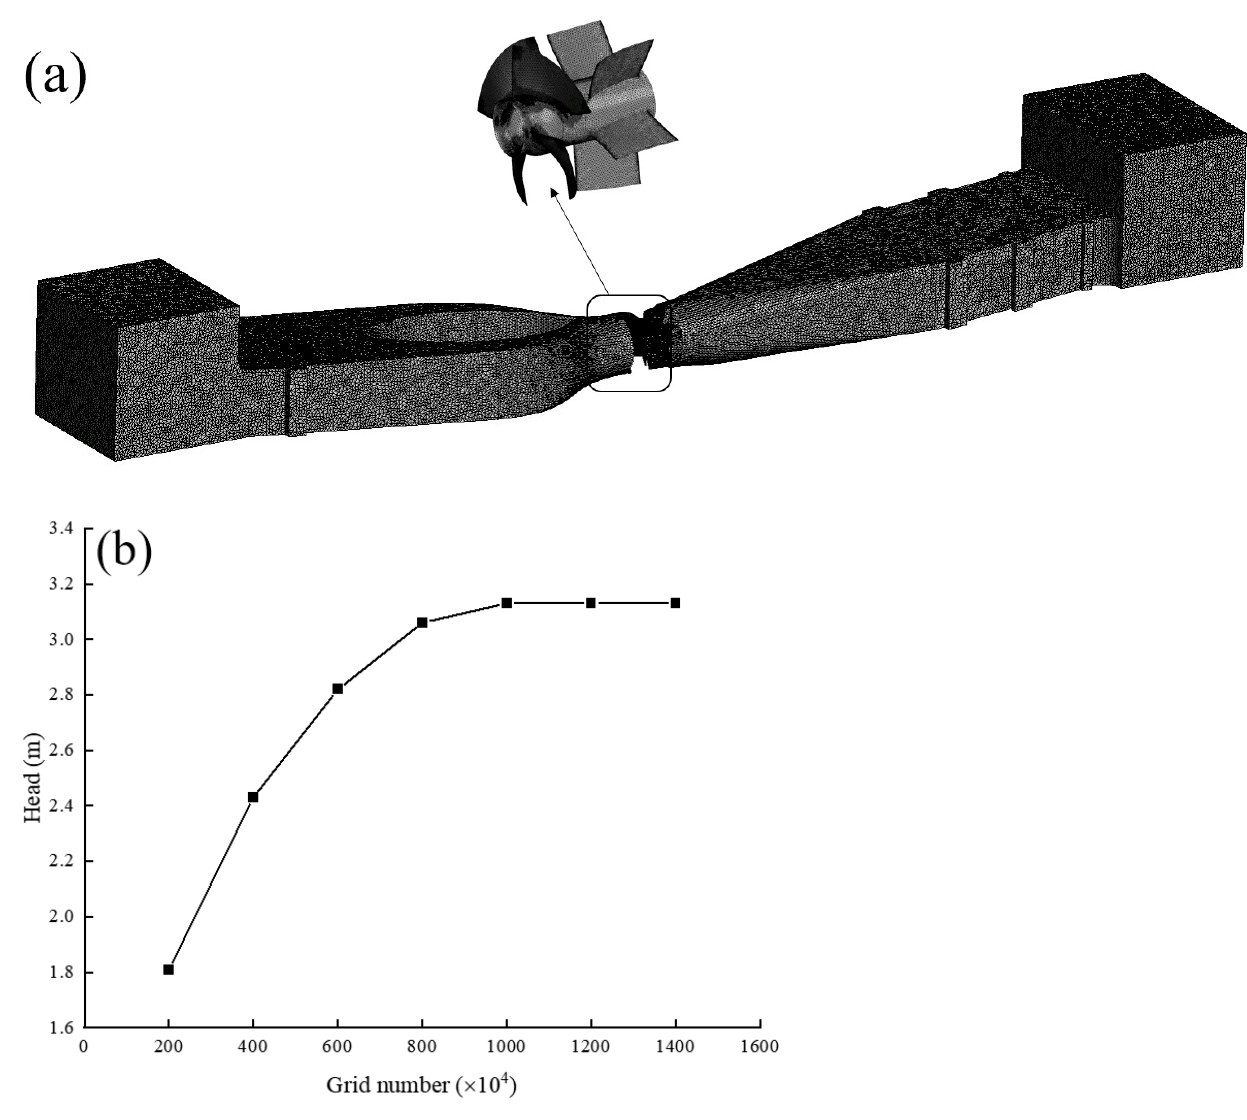
Figure 8. Mesh of CFD model: ( a ) grid of fluid domain and ( b ) mesh independence tests. The comparison between the numerical calculation results and the experimental